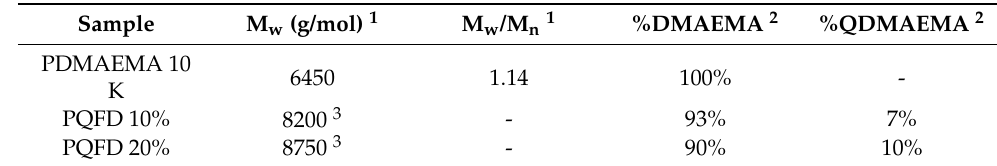
Table 1. Molecular characteristics of the PDMAEMA precursor and the quaternized PQFD am- phiphilic copolymers.